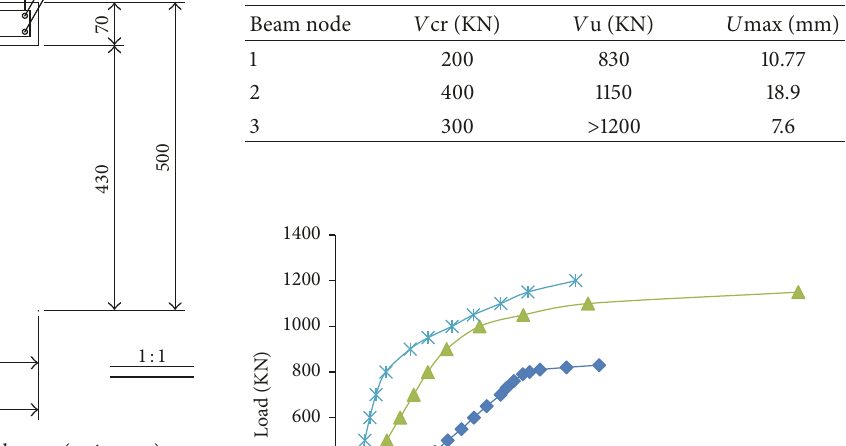
Figure 1: Section size and reinforcement layout (unit: mm).